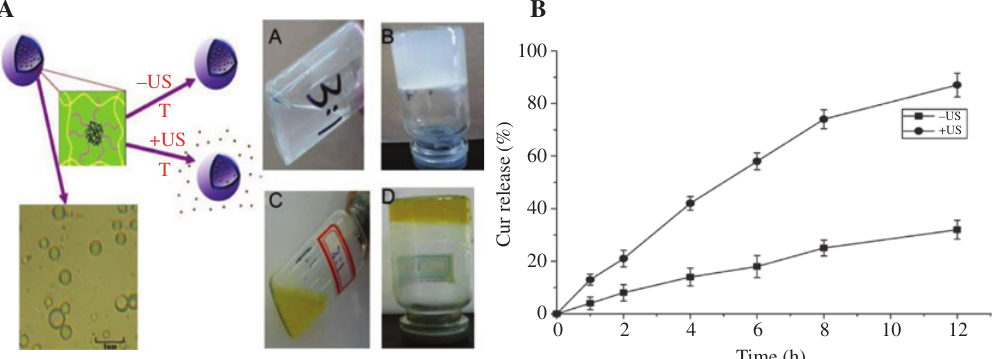
Figure 14: (A) Schematic illustration of Cur-LM-G and the external morphology of the blank liposome microbubble gel is shown at the middle: (A) under the temperature of gelation, (B) gelation process, (C) the formed Cur-LM-G under the temperature of gelation, and (D) gelation. (B) The percentage of curcumin that is released from Cur-LM-G in the presence and without the presence of US. Reprinted with permission from Ref. [206], copyright 2013,